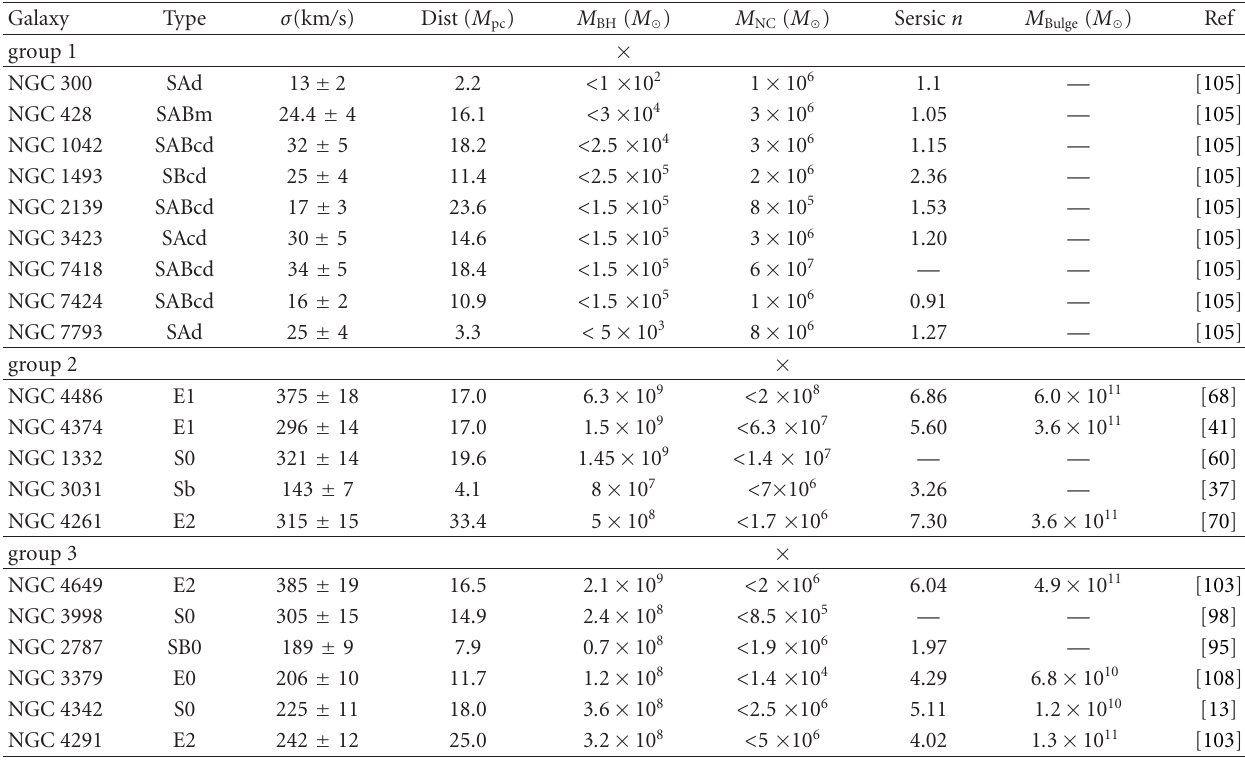
Table 2: Sample of galaxies for which new properties were derived in this